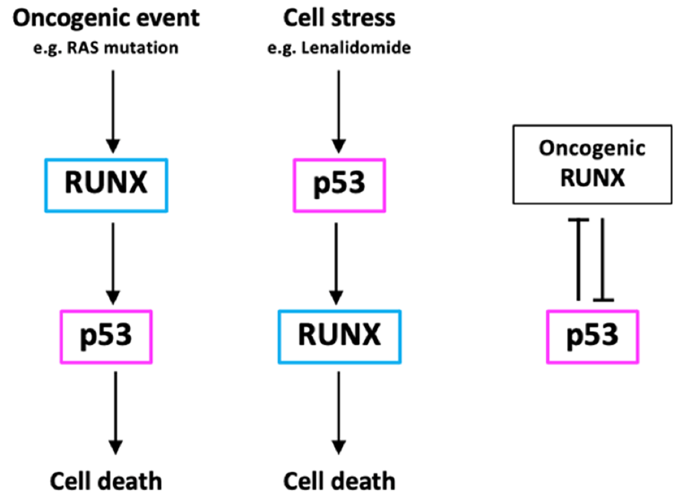
Figure 2. Bidirectional relationship between RUNX and p53. Wild-type RUNX and p53 positively regulate each other via transcriptional and non-transcriptional mechanisms dependent on the type of stimulation, whereas oncogenic RUNX and wild-type p53 negatively regulate one